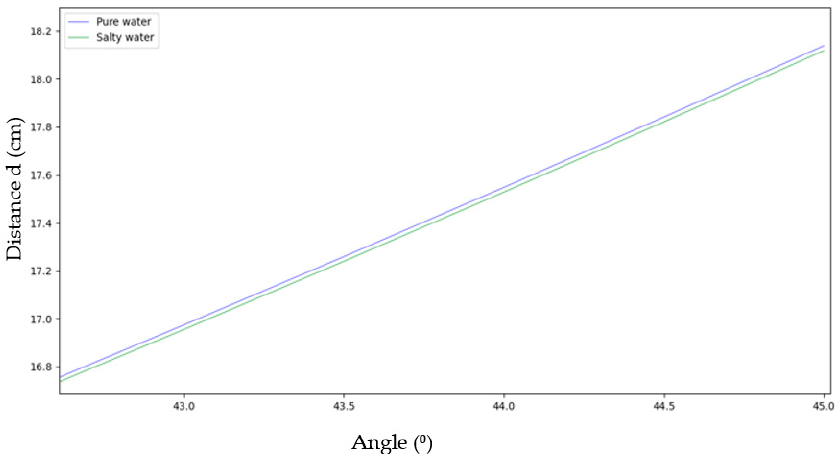
Figure 7. Effect of the water sample nature on the distance d for different angle of incidence θ i at λ = 660 nm, T = 30 ◦ C, and W water = 5 cm .